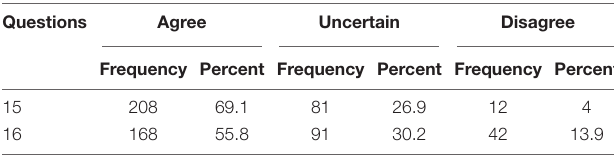
TABLE 12 | Frequency and percent of the questions related to the learners’ technophobia in technology integration learning environments. Questions